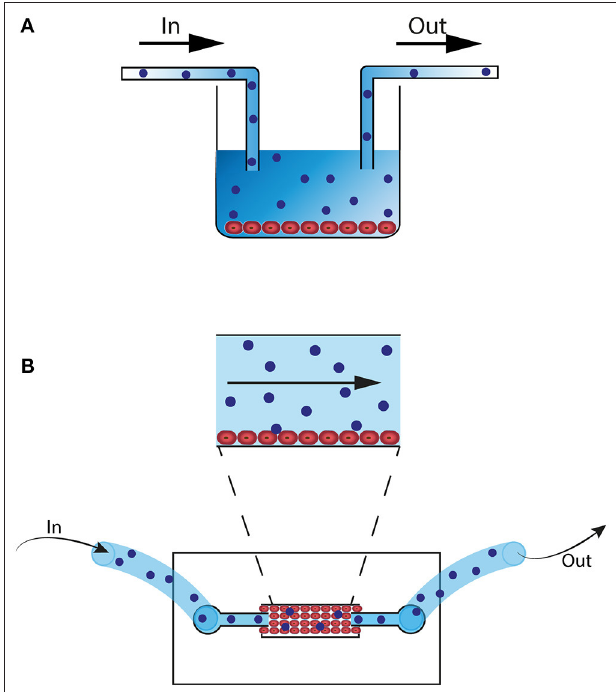
FIGURE 1 | 2D microfluidic in vitro models. (A) Culture well with HUVEC or organ-specific EC (red). The well is connected with a pump (not shown) and flow tubes. Alloreactive lymphocytes (blue) are perfused through the well. (B) 2D Microfluidic chip that can be connected to a pump (not shown) and flow tubes. EC (red) are perfused through the system and cells attach to the bottom of the chip. Next, alloreactive lymphocytes (blue) are perfused through the